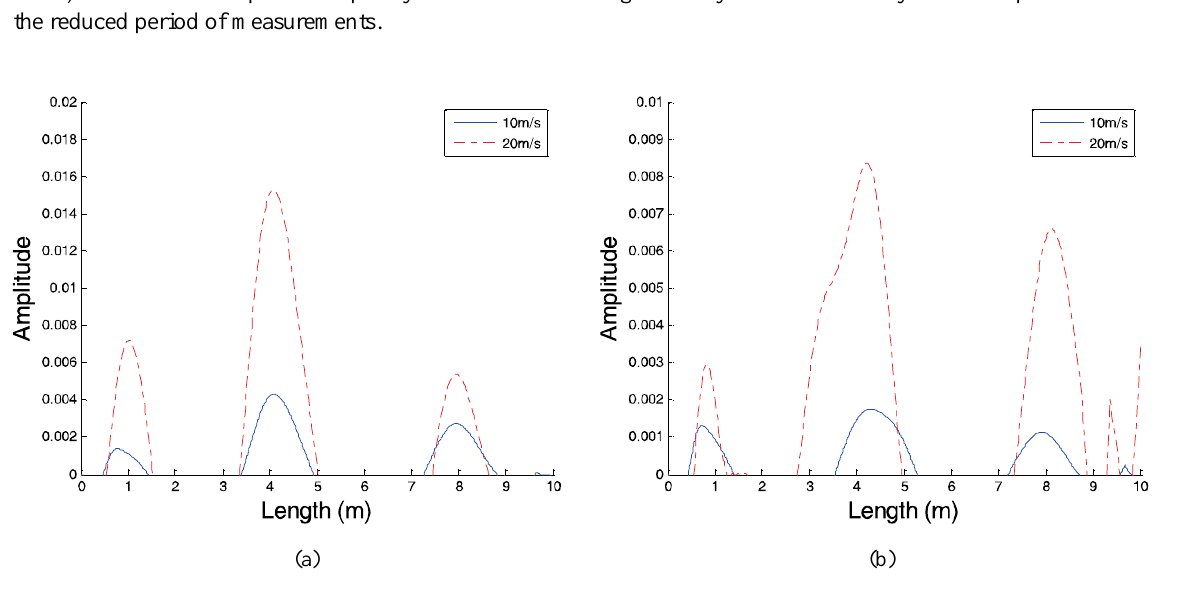
Fig. 6. IMF 1 from load velocities of 10 and 20 m/s with δ of (a) 0.2 and (b) 0.1 at 4 m and 8